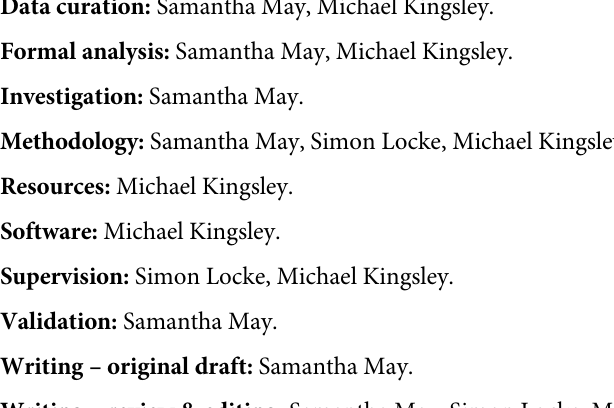
S1 Table. Inter-rater reliability: Pairwise comparisons between Investigators A, B and C for fascicle length, pennation angle and muscle thickness of the gastrocnemius medialis and gastrocnemius lateralis muscles. IQR = interquartile range; ICC = intra-class correlation coefficient; CI = confidence interval; RLOA = ratio limits of agreement; mm = millimetres; ˚ =